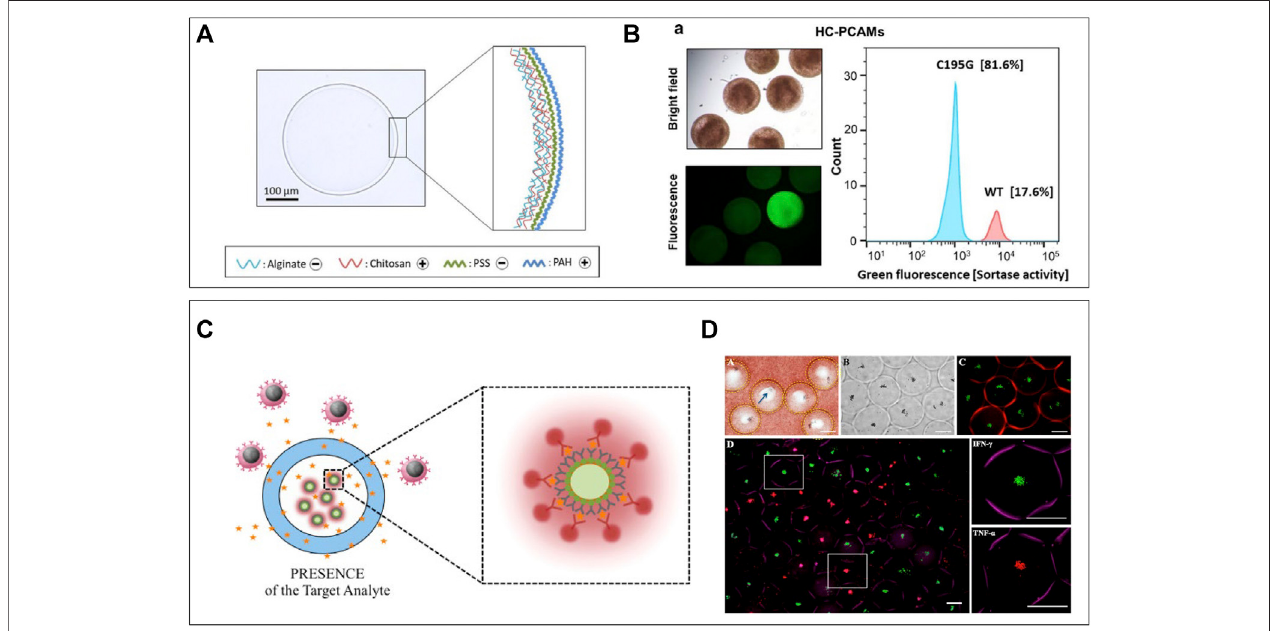
FIGURE 7 | Semi-permeable hydrogel shells. (A) Hydrogel shell droplets are coated with polyelectrolytes to decrease permeability. This successfully allows the diffusion of nutrients and lysis buffer, but keeps DNA inside after lysis. (B) Particles can be analyzed and sorted based on fl uorescence in a large particle sorter (di Girolamo et al., 2020). (C) Selectively permeable hydrogel shell particles used as sensors preventing cells to reach the microbeads but letting cytokine and detection antibodiesdiffusein. (D) Sensorparticlessubmergedinwholebloodandafterwashingandincubationwithdetectionantibodies. IFN- γ speci fi cparticlesaregreen, and TNF- α speci fi c particles are red (Rahimian et al.,